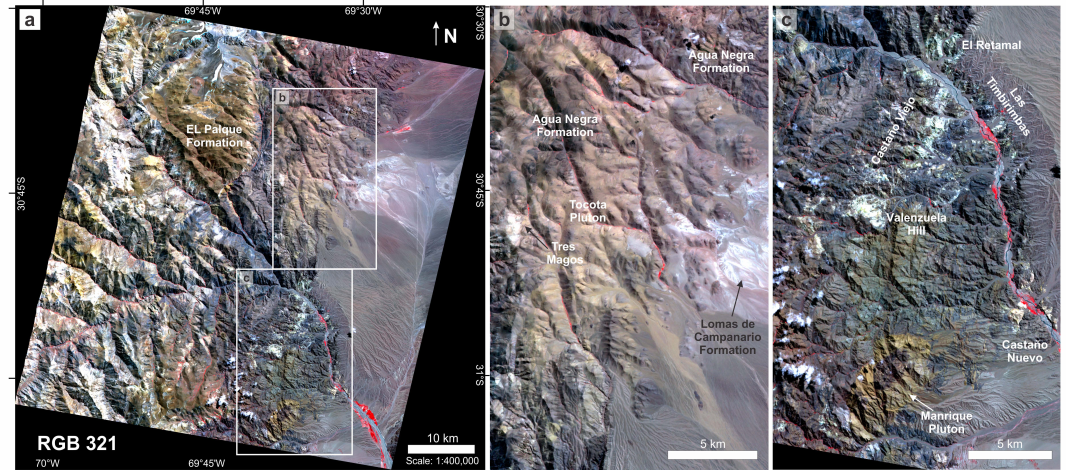
Figure A1. ( a ) False color composite image with ASTER bands 3, 2, 1 (RGB). ( b ) The San Francisco de los Andes district: Tocota pluton (orange brown), and Loma del Campanario (white). ( c ) The Castaño area: argillic – phyllic and silicic alterations (whitish color). Compare the current ASTER imagery with the geologic map in Figure 3.